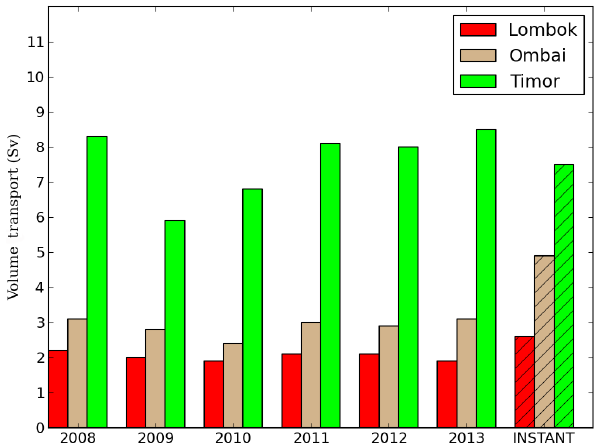
Figure 14. Model volume transport (Sv) into three main exits: Lom- bok (red), Ombaï (Brown), Timor (green) at different years. The Instant estimates (2004–2006) are shaded.